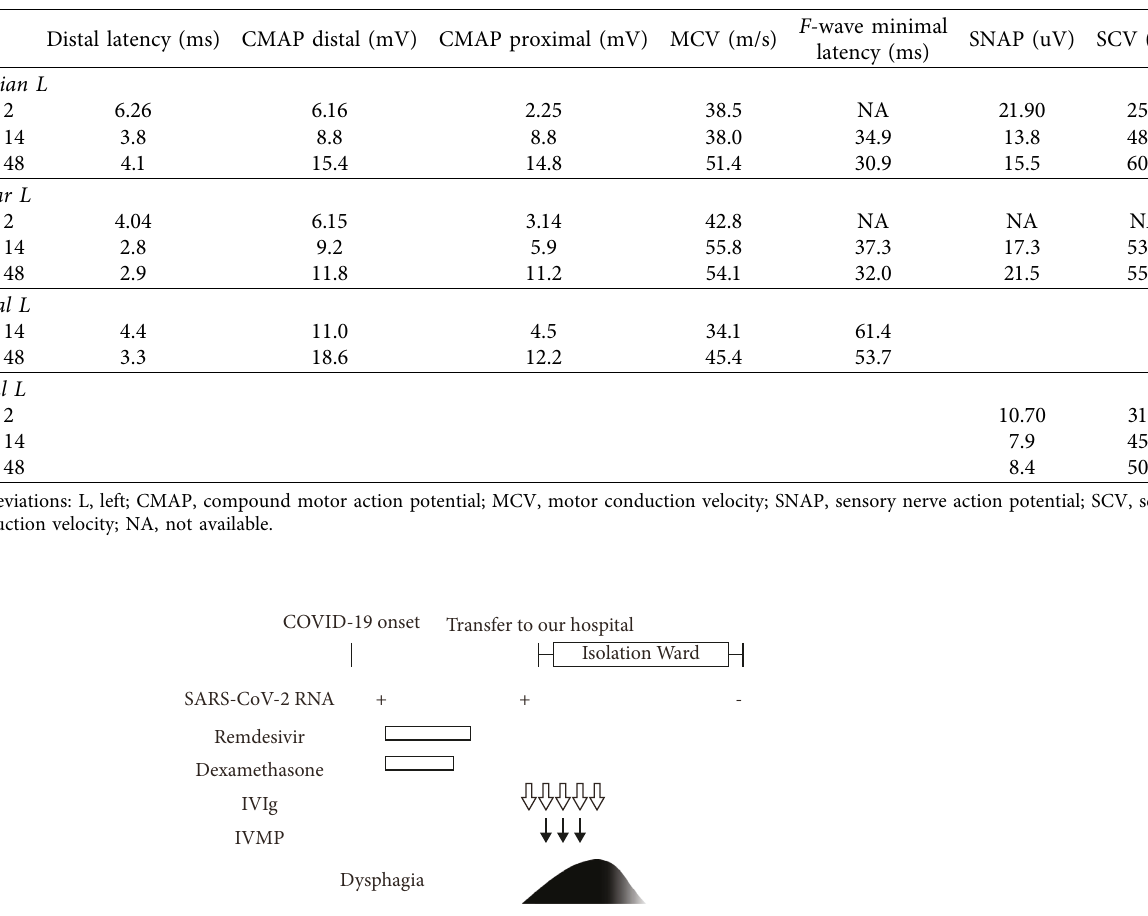
Table 1: Results of the nerve conduction studies during the clinical